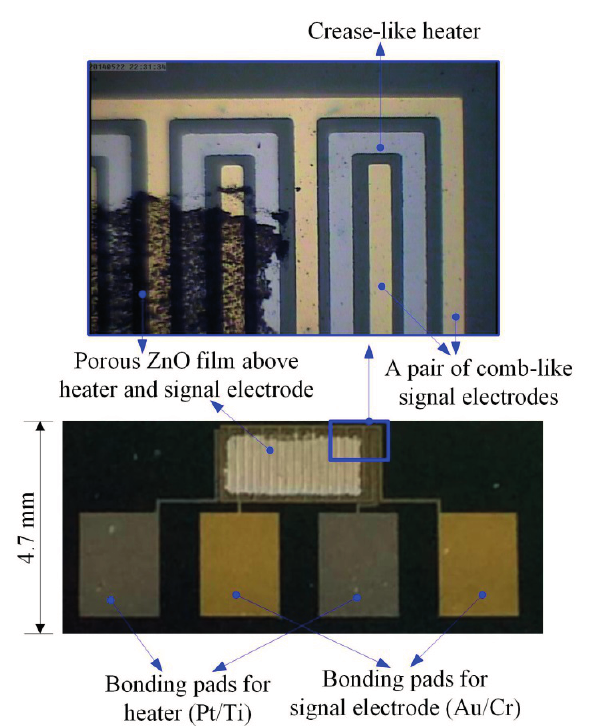
Figure 4. Fabricated ZnO gas